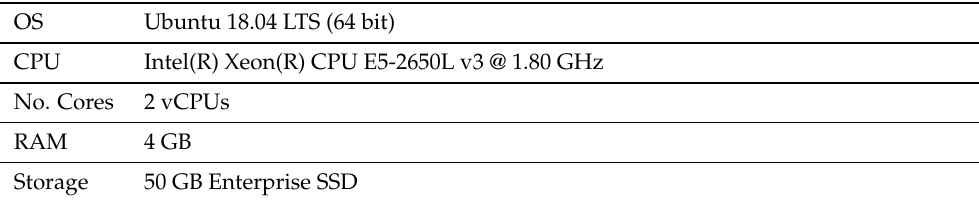
Table 2. Virtual machine configuration.